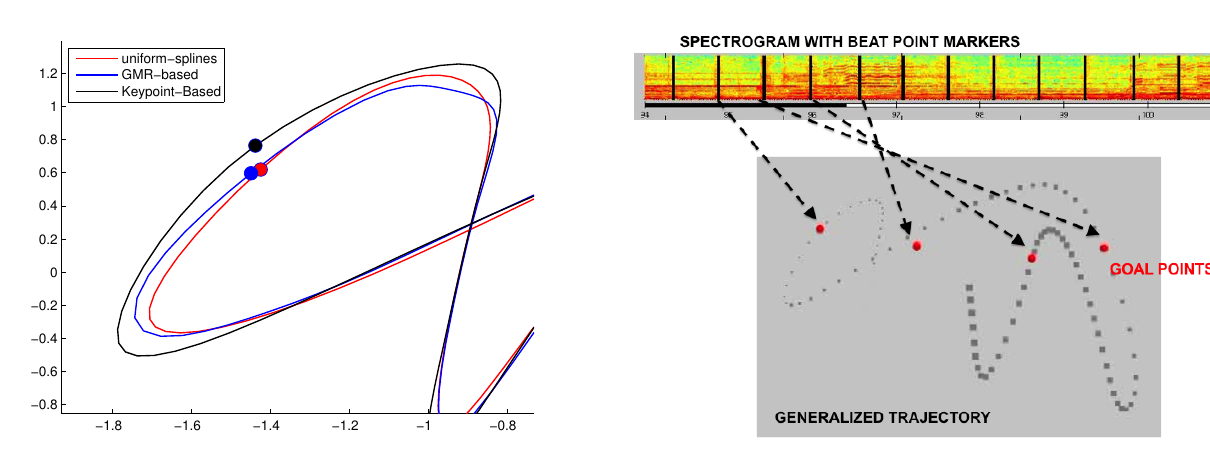
makes the generalised trajectory also normalised and easily scalable. Scales can be chosen in accordance with musical